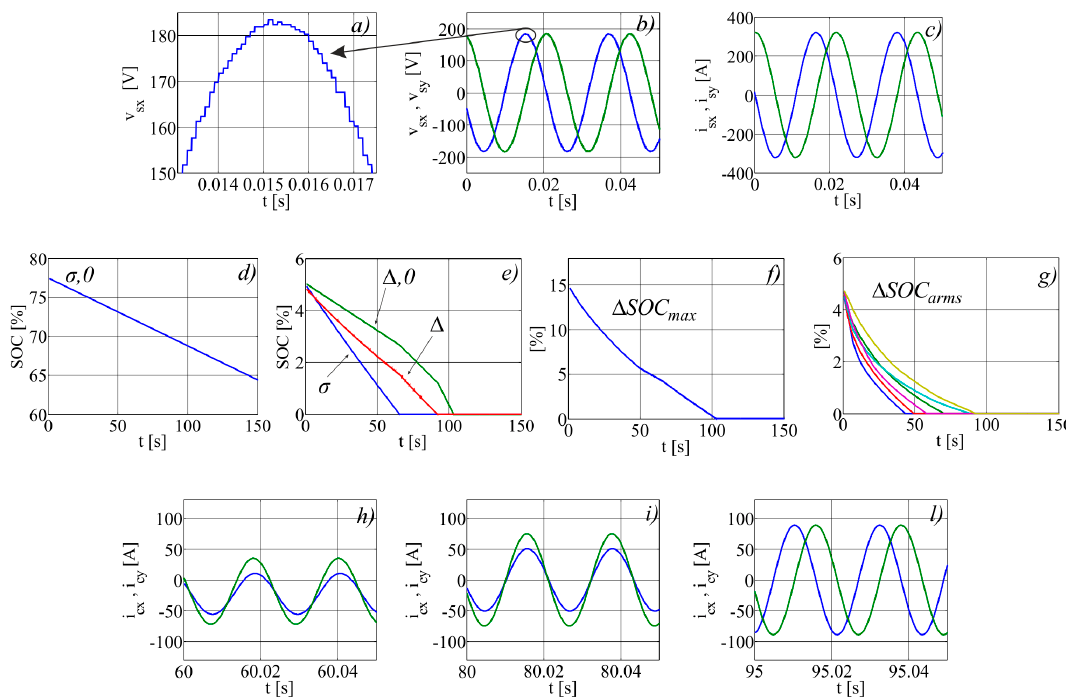
Figure 3. Numerical results for high speed: ( a ) zoom of x motor voltage component; ( b ) x,y motor voltage components; ( c ) x,y motor current components; ( d ) half of the zero-sequence component of the arms sum SOCs; ( e ) unbalance state of charge (SOC) terms; ( f ) difference between the maximum and the minimum SOC of all the cells; ( g ) difference between the maximum and the minimum SOC of the six arms; x,y circulating current components when all three hysteresis regulators are ON ( h ), only two regulators are ON ( i ); and, only one regulator is ON ( l ).